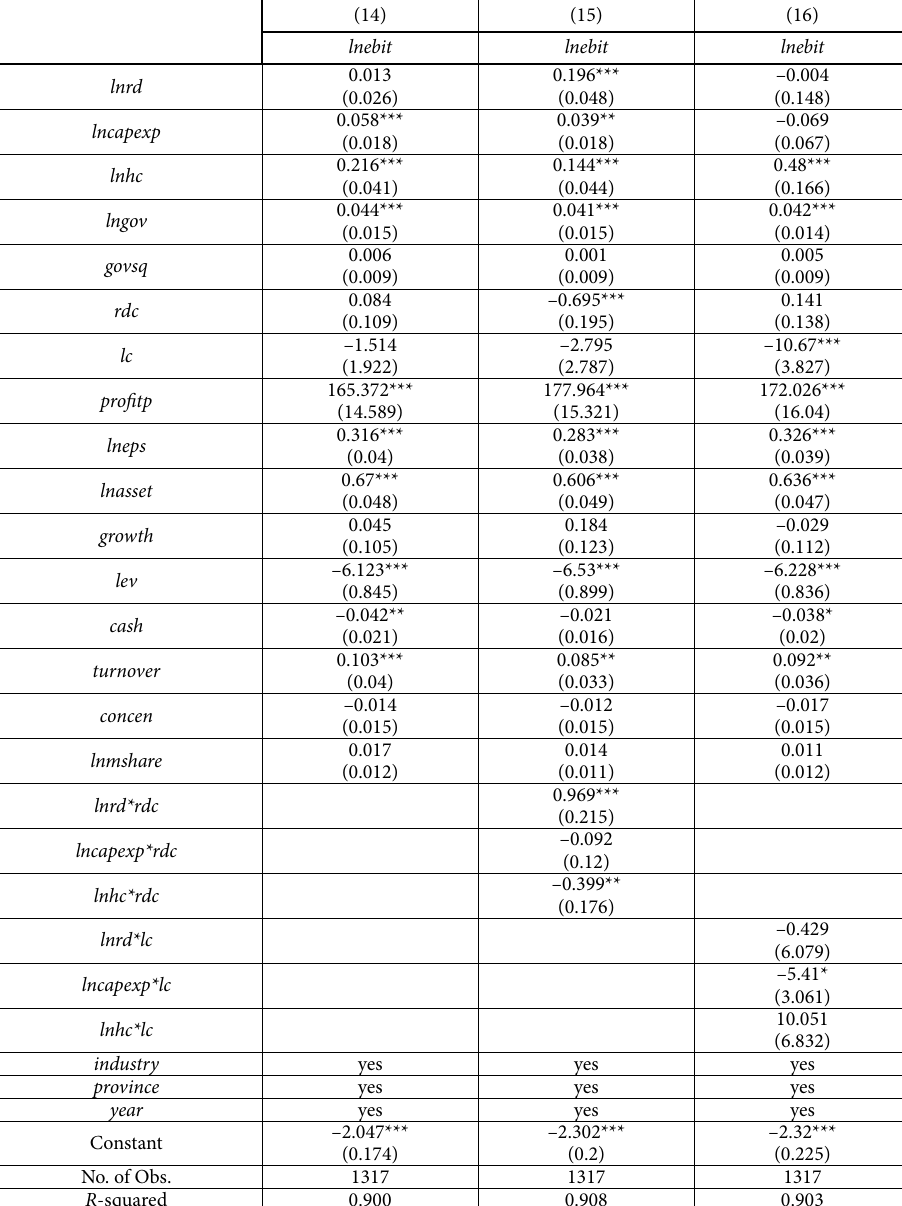
Table A1. Robustness test for non-linear relationship of government